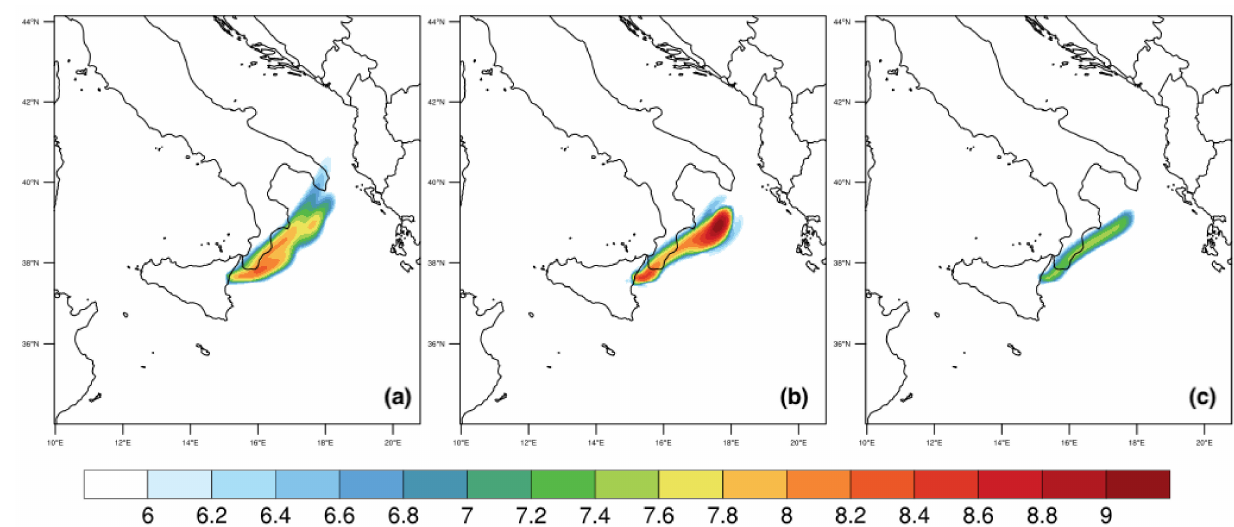
Figure A3. The columnar quantity ( Vash col , µ g m − 2 ), in log 10 scale, for ( a ) run3, ( b ) run4 and ( c ) run5 configurations, all at 12:00 UTC on 23 November